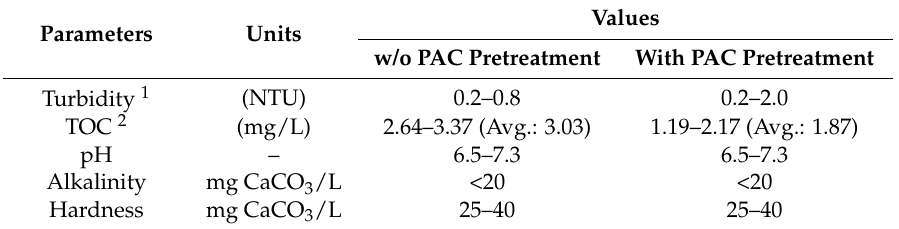
Table 1. Feed water quality with and w/o powdered activated carbon (PAC) pretreatment.